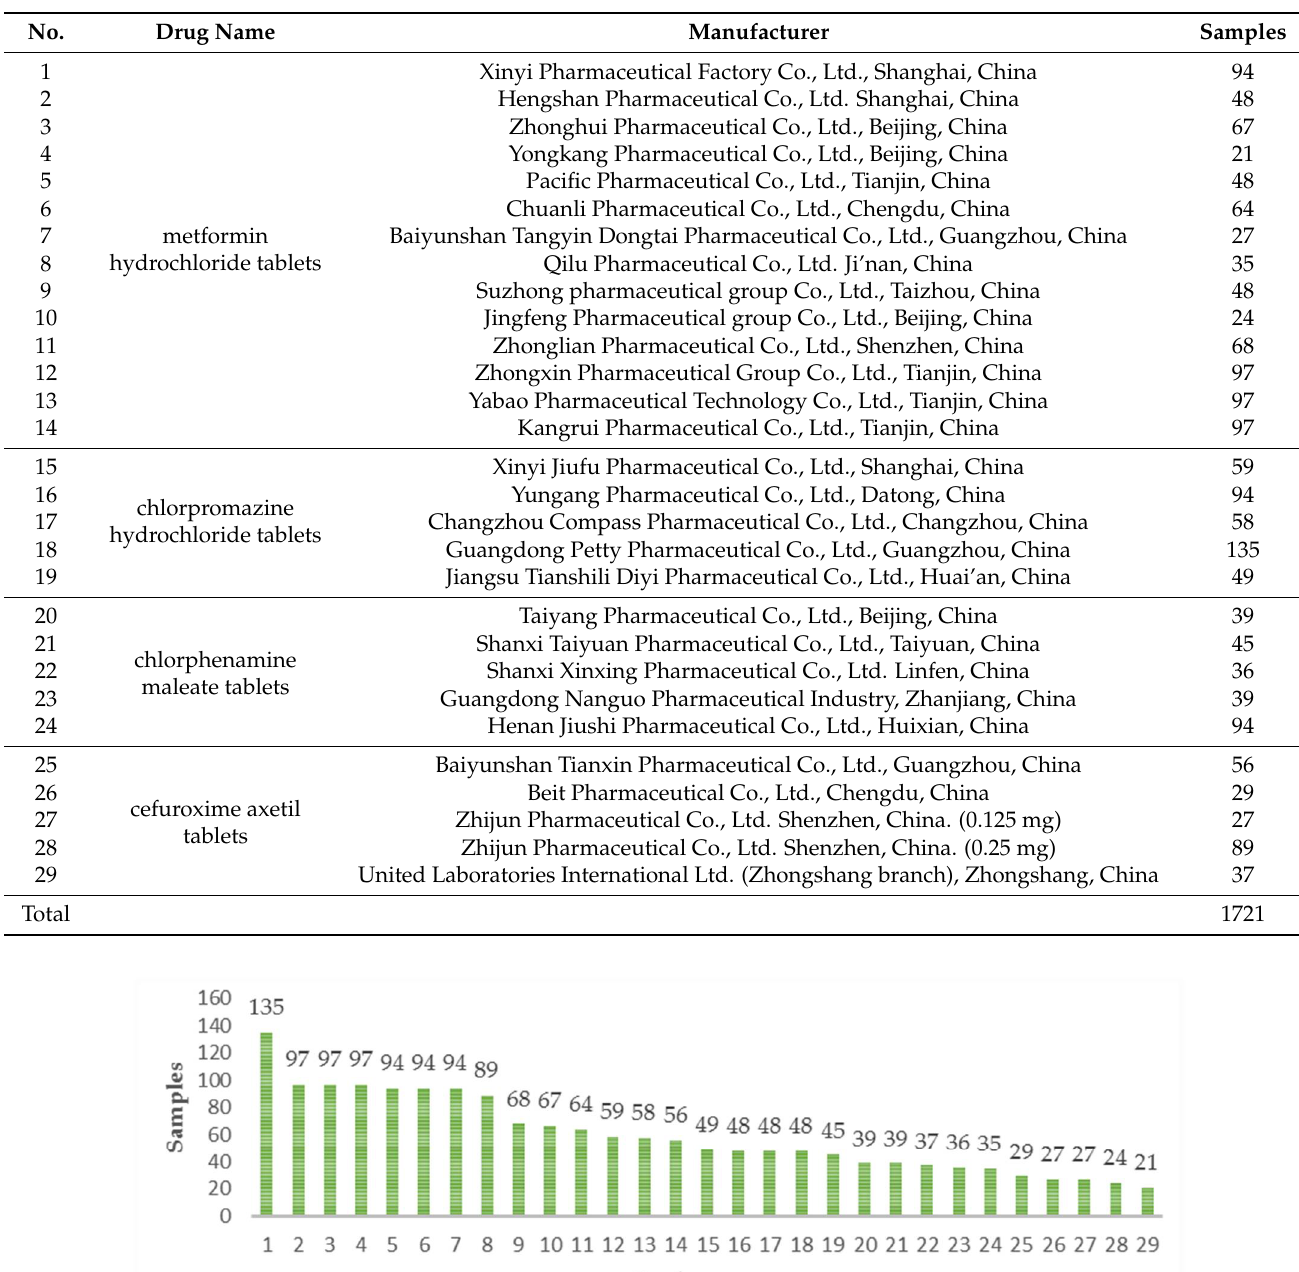
Table 1. Drug Names, Manufacturers, Sample Names of the material used in this paper. No.